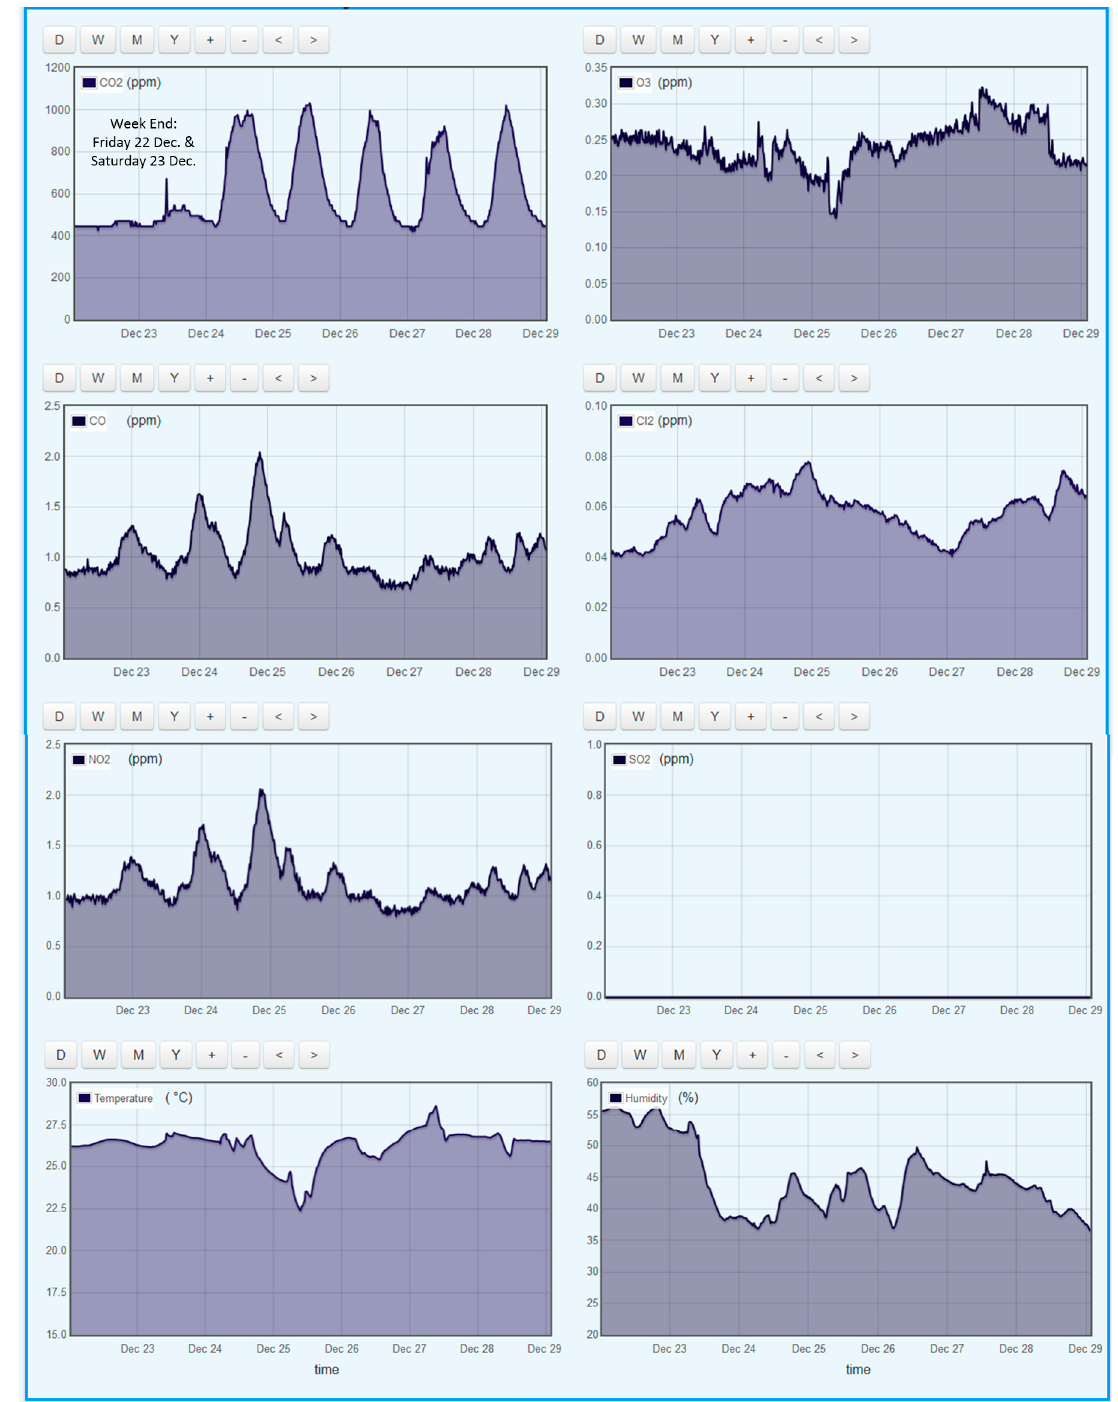
Figure 12. Indoor air quality data (as displayed by the online Emoncms IoT) collected in an office space at Qatar University during December 2017.